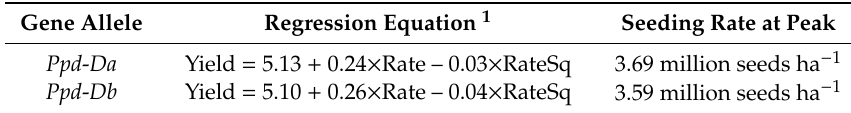
1 Regression equation from SAS (PROC REG)